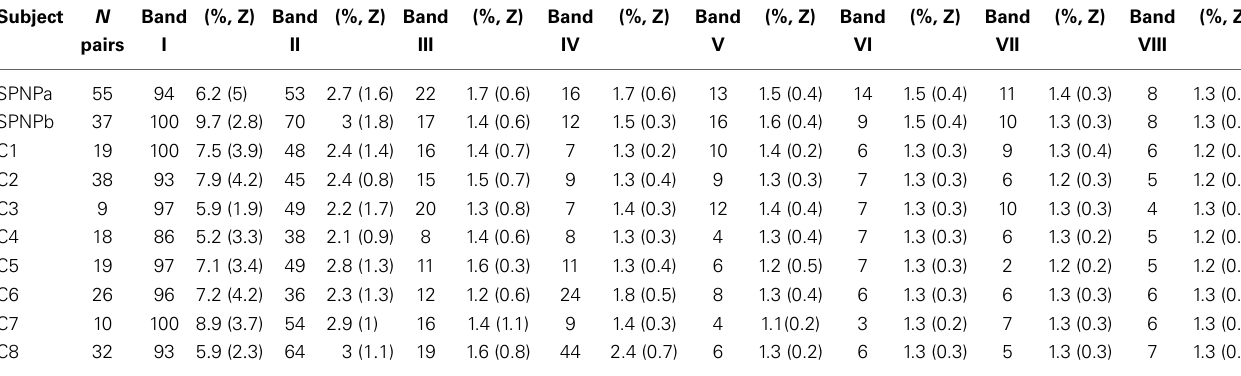
Table 2 | MU pairs coherence